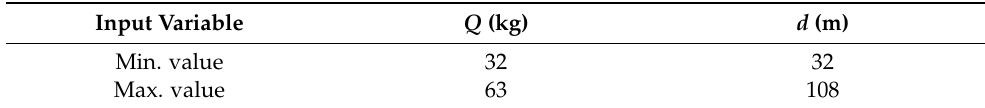
Table 6. Limit values of each input variable.